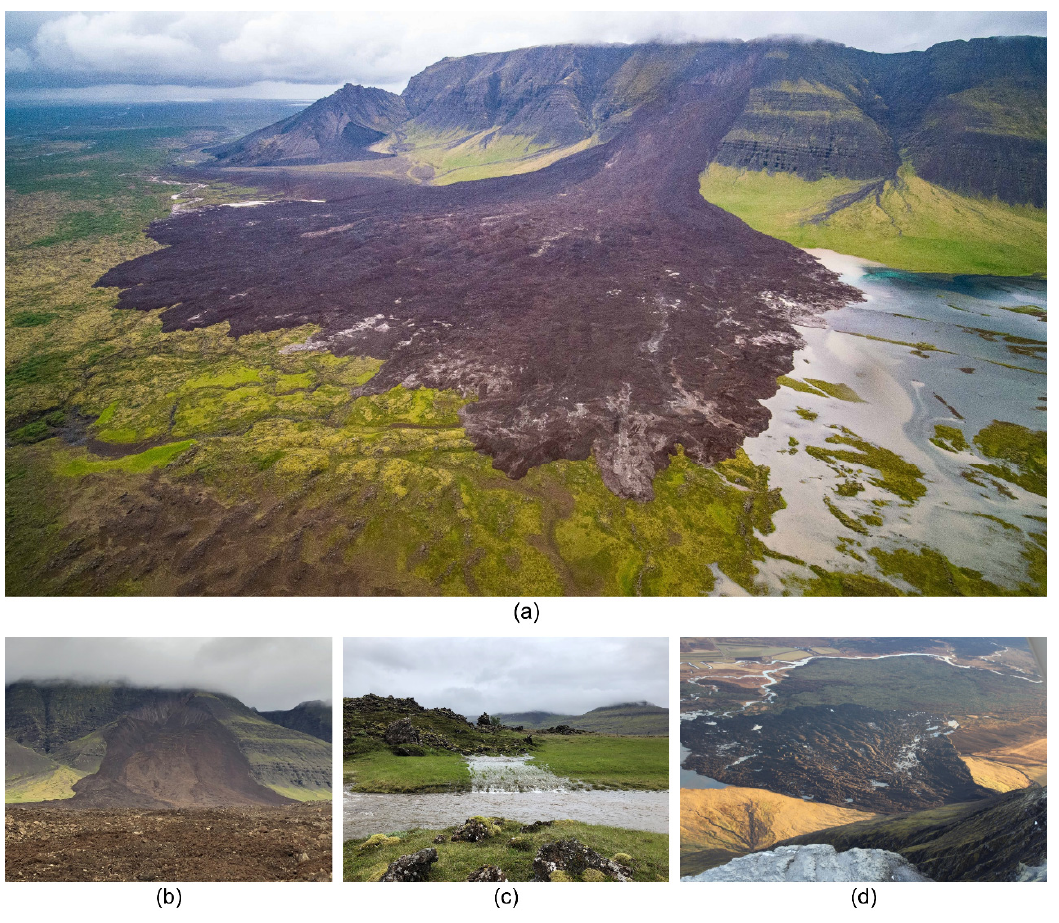
Figure 2. ( a ) Photograph showing the Hítardalur landslide and the landslide-dammed lake soon after the event occurred, i.e., taken on the afternoon of 7 July 2018 (photograph: © S. Asgeirsson). ( b ) View from the landslide deposition area towards the landslide source area (photograph: © J. K. Helgason; 7 July 2018). ( c ) Water from the dammed lake finds a new way (photograph: © J. K. Helgason; 7 July 2018). ( d ) View from the Fagraskógarfjall mountain towards the Hítardalur valley showing the